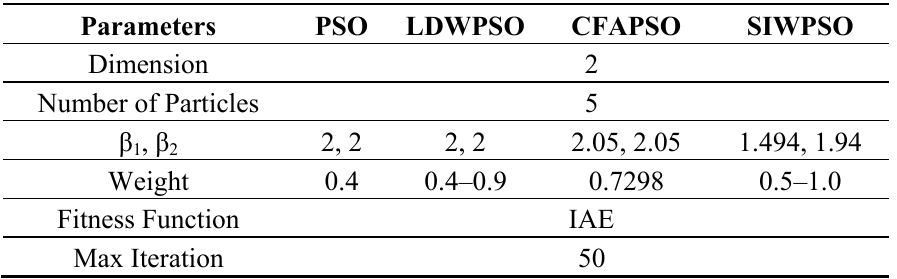
Table 3. The PSO parameters.